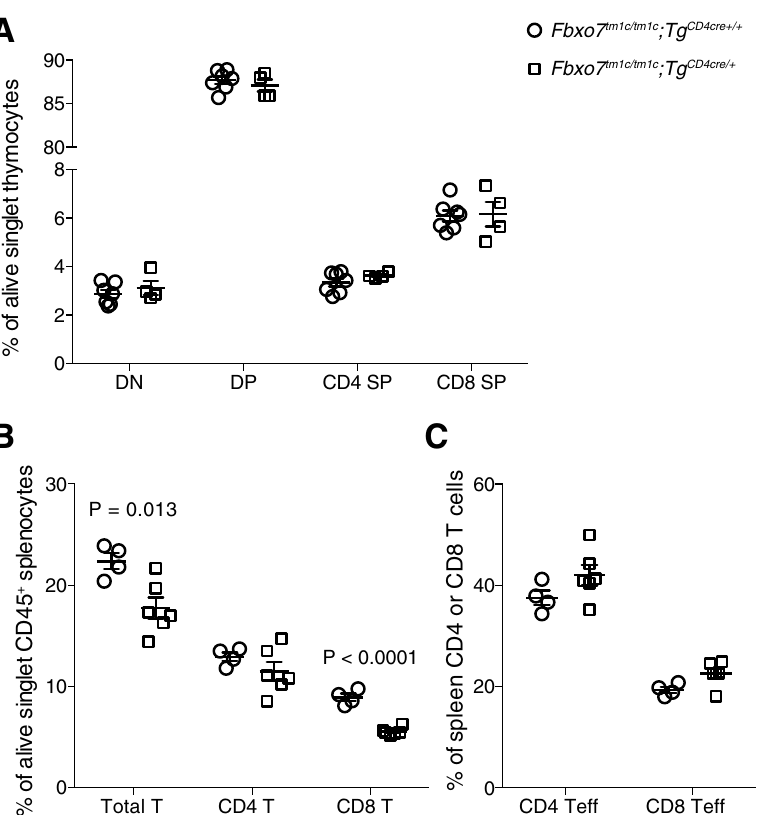
Fig 4. Fbxo7 has a T cell intrinsic role in controlling T cell number in the periphery but not phenotype. (A) T cell developmental stages in the thymus, DN = CD4/CD8 double negative, DP = CD4/CD8 double positive, CD4 SP = CD4 single positive and CD8 SP = CD8 single positive. (B) T cell percentage in the spleen and (C) splenic T cell effector percentage. P values from an unpaired two-tailed students t test with Holm-Sidak multiple testing correction. All data representative of three independent experiments (spleen 16–20 week old female mice, thymus 12–14 week old male mice), each symbol represents an individual mouse with the line at the mean and error bars represent standard error of the